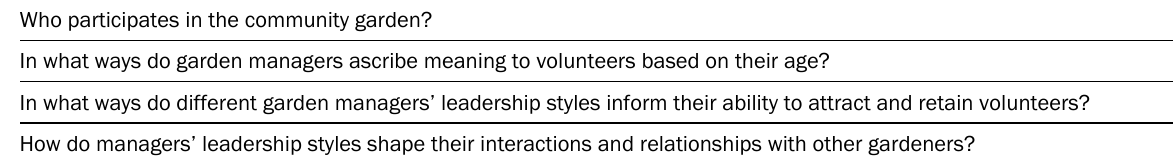
Table 4. Garden Manager Pseudonyms and Garden Characteristics Garden Manager